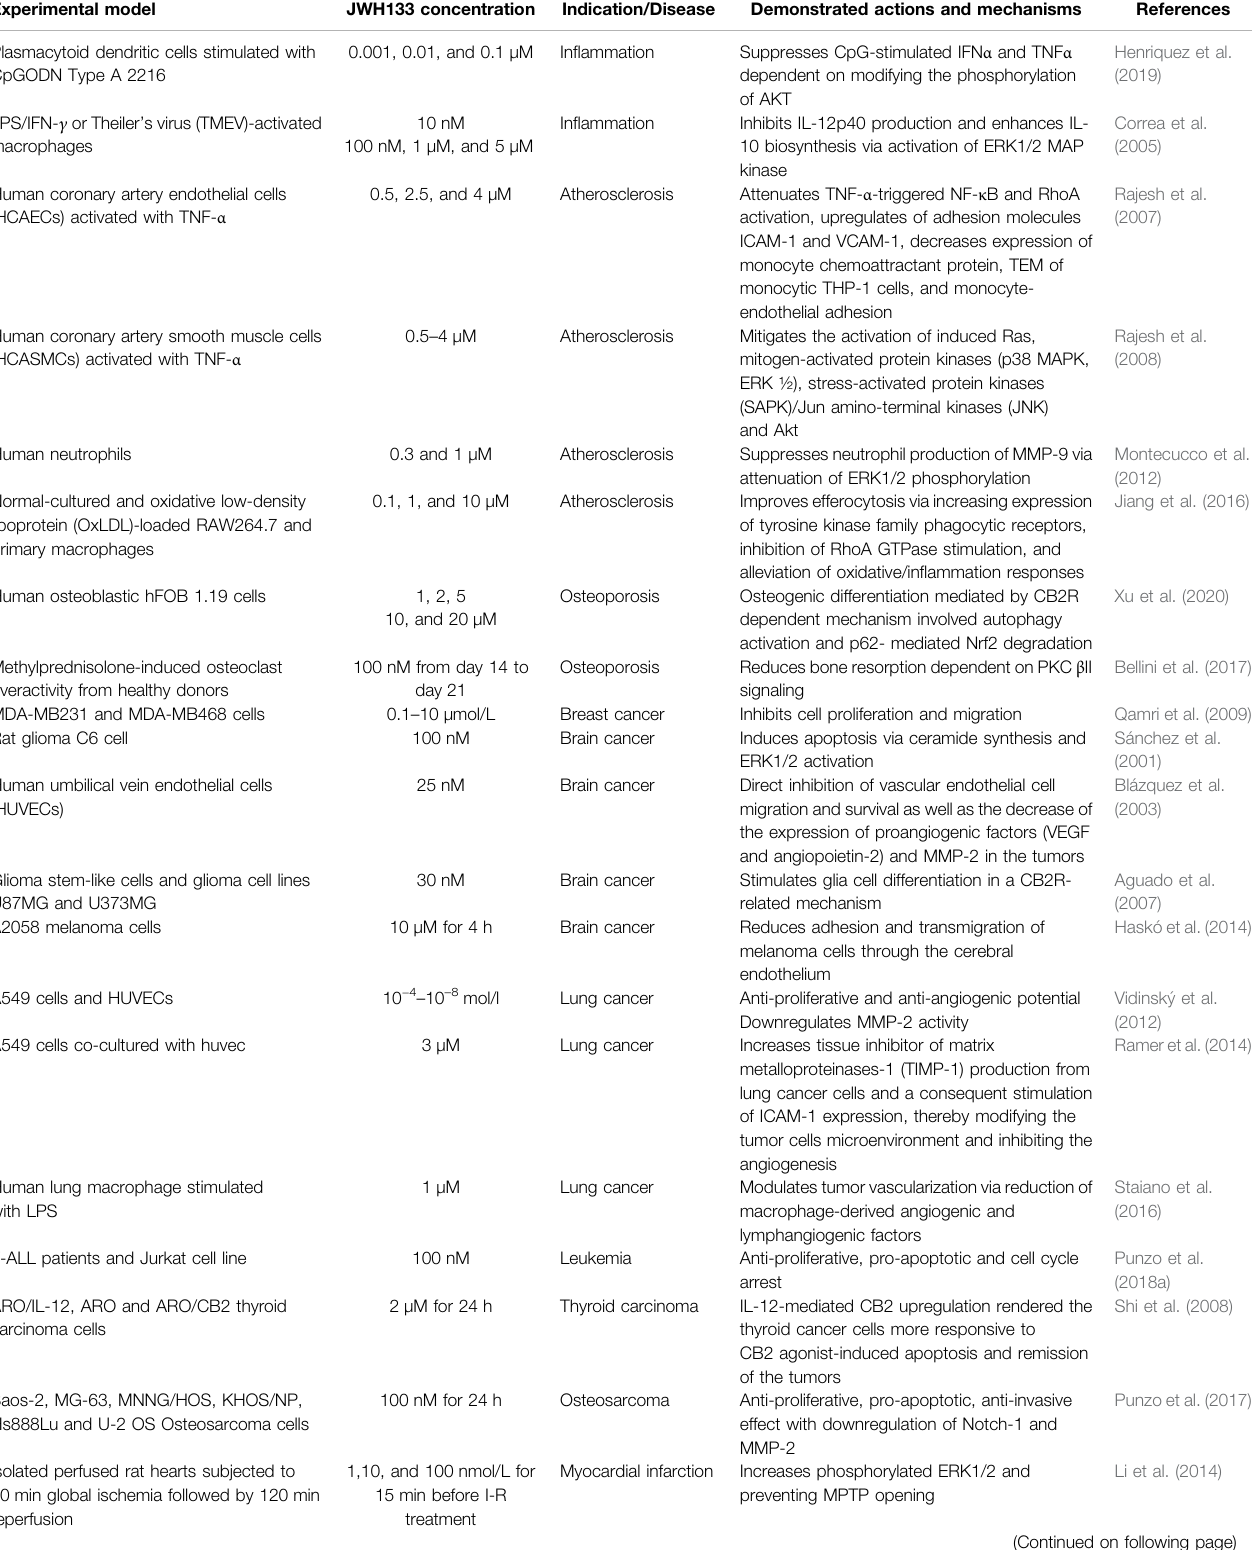
TABLE 3 | Pharmacological activities, mechanism and therapeutic potential of JWH133 in the in vitro